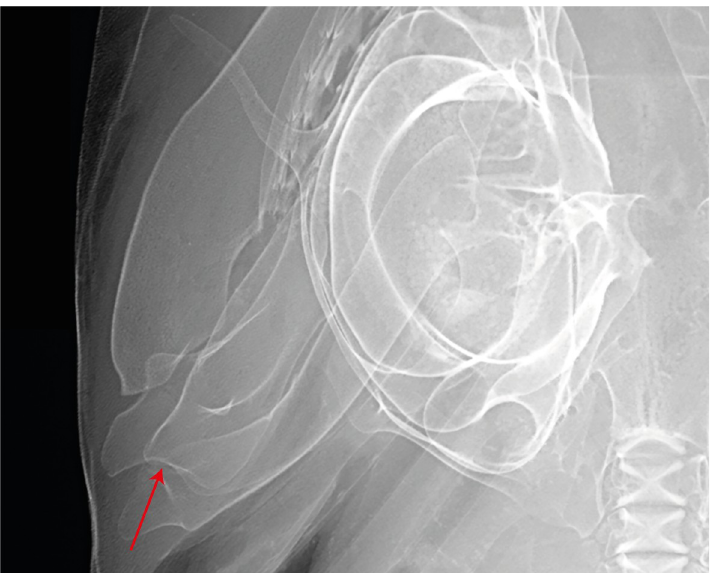
Fig 3. Post-mandibular indentation of Meckel’s cartilage in Carcharhinus obsolerus sp. nov. Radiograph of head of ANSP 77121, paratype; 433 mm TL female; arrow denotes